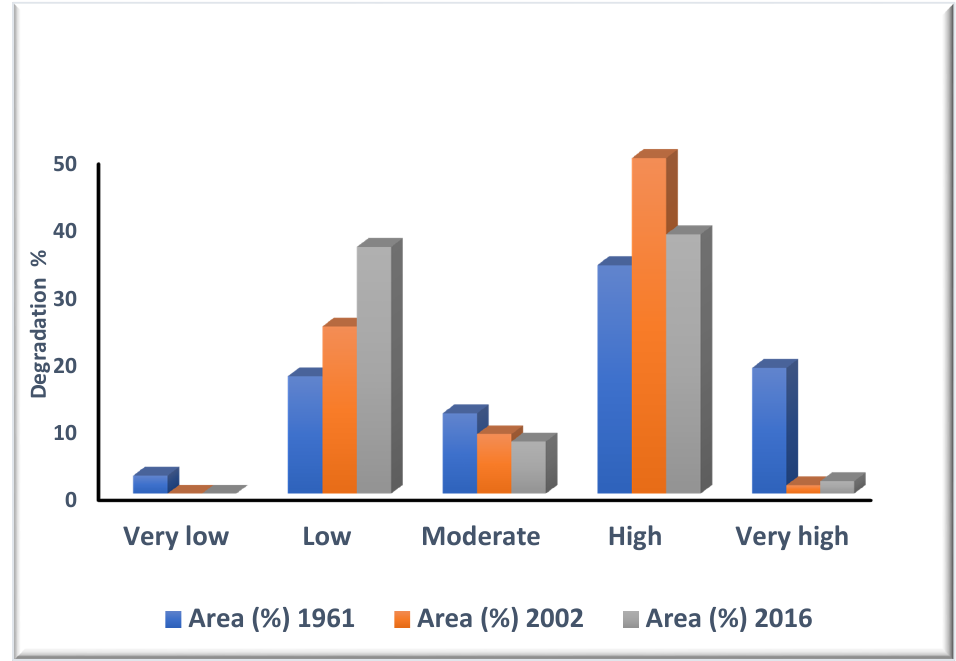
ISPRS Int. J. Geo-Inf. 2022 , 11 , x FOR PEER REVIEW